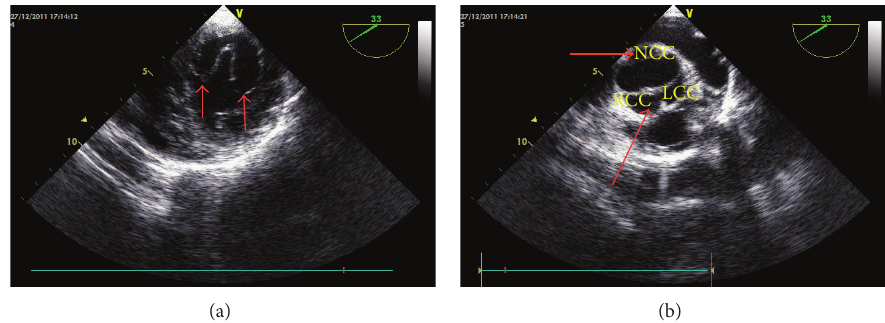
Figure 2: Modified section of mitral valve and short axis view of the bicuspid aortic valve with fusion of the left and right coronary cusps (LCC and RCC) in transesophageal